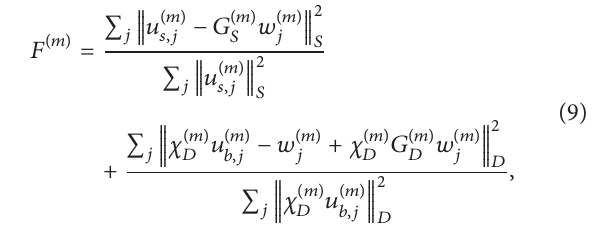
Figure 2: The flowchart of the two-stage imaging